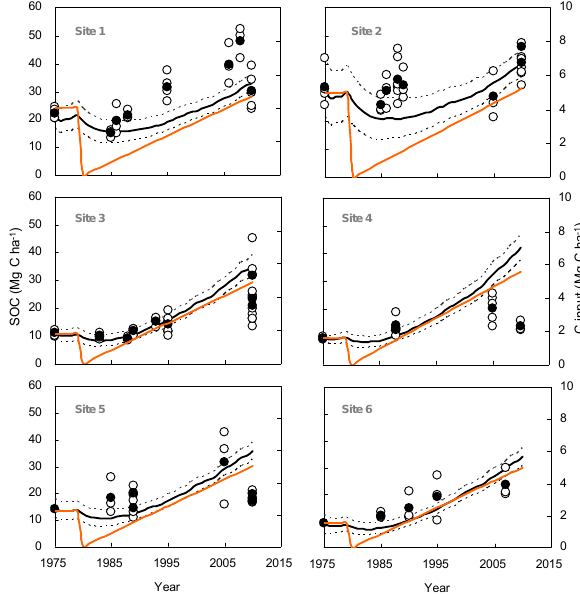
Fig. 6. Comparison of simulated and measured SOC stock in the 0– 20cm soil depths following afforestation. The first y axis represents SOC stock. The second y axis represents litter carbon biomass.